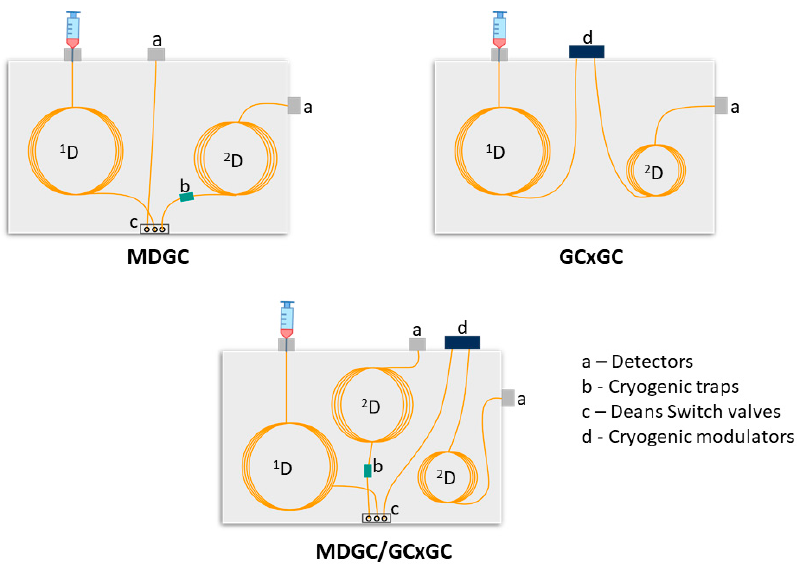
Figure 1. Simplified schematic examples of di ff erent multidimensional systems: MDGC, GC × GC and integrated MDGC / GC × GC.